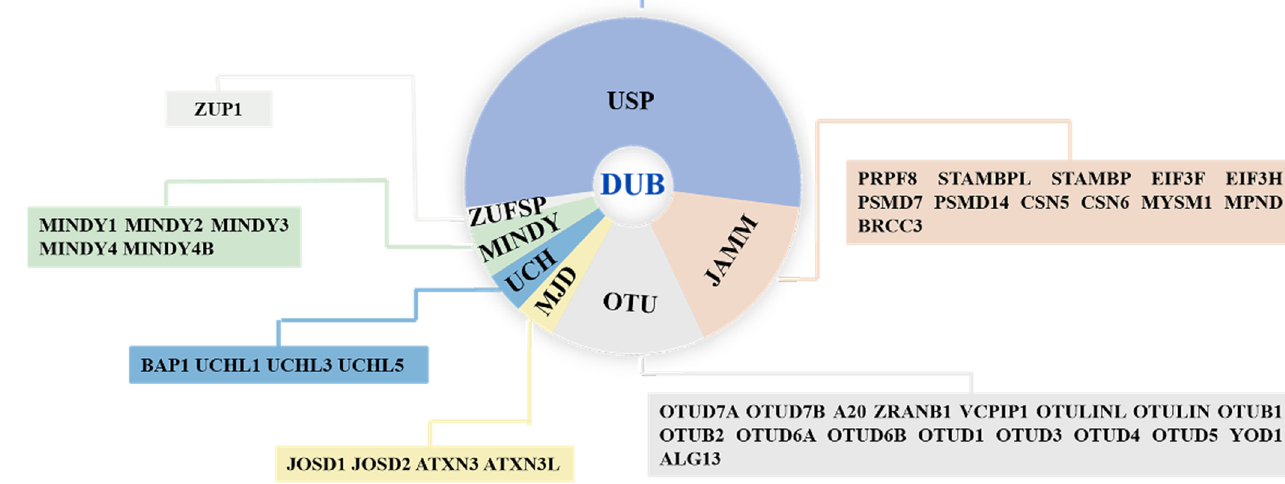
Figure 1. The classification and members of DUB family. DUBs are divided into seven subfamilies: ubiquitin-specific proteases (USPs), ubiquitin carboxy-terminal hydrolases (UCHs), ovarian tumor proteases (OTUs), Jab1/MPN domain-associated metalloenzymes (JAMMs), Machado–Joseph disease proteases (MJDs), monocyte chemotactic protein-induced protease family (MINDYs), and Zn-finger and UFSP domain proteins (ZUFSPs).